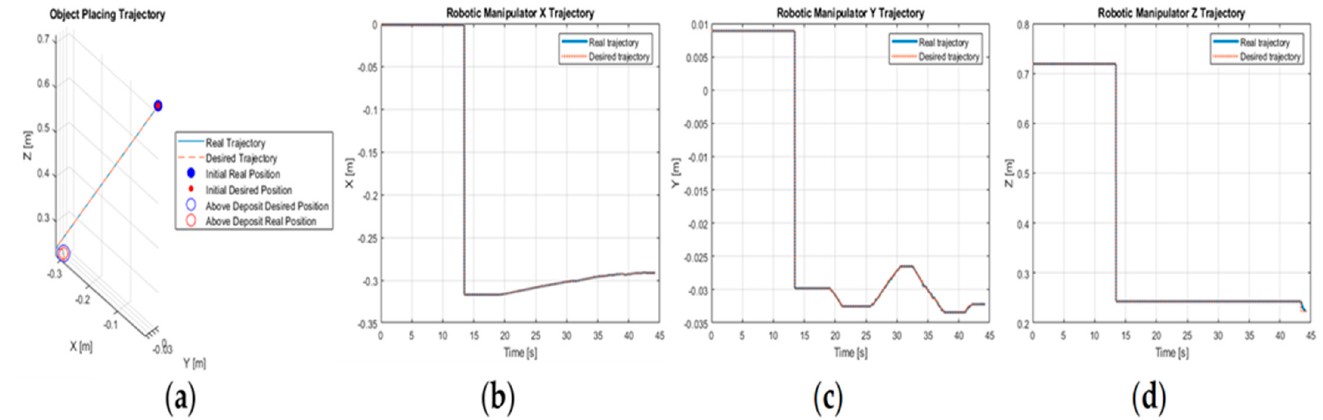
Figure 27. Desired and real object placing trajectories of the RM Cyton based on inverse kinematics control and eye-in-hand VSS for positioning at the warehouse: ( a ) signifies the complete trajectory, while ( b ), ( c ), and ( d ) are the trajectories separated on the X, Y, and Z axes, respectively.